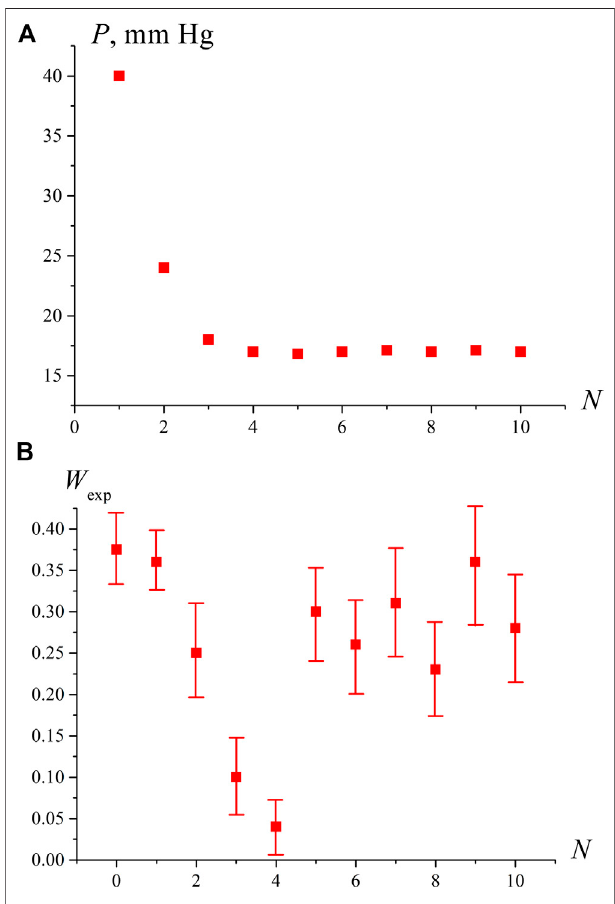
FIGURE 2 | Dependence of pressure P in the free volume of the cell [panel (A) ] and the probability of optical breakdown W exp [panel (B) ] dependingonthedegassingnumber N .Itcanbeseenthatwhenthepressure P in the free volume reaches the saturated vapor pressure ( N ≥ 4), the probability of breakdown increases sharply.